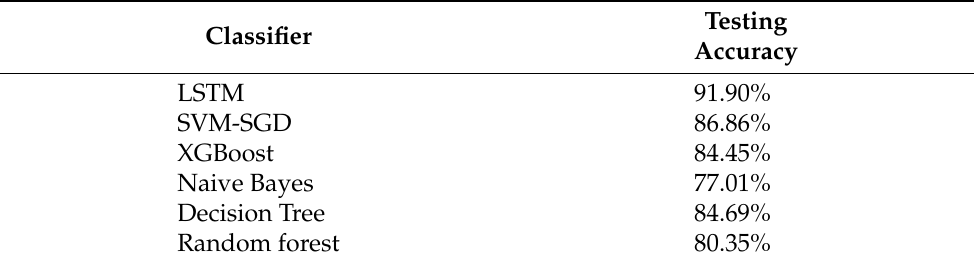
Table 1. Performance of the classification methods applied on the testing dataset.